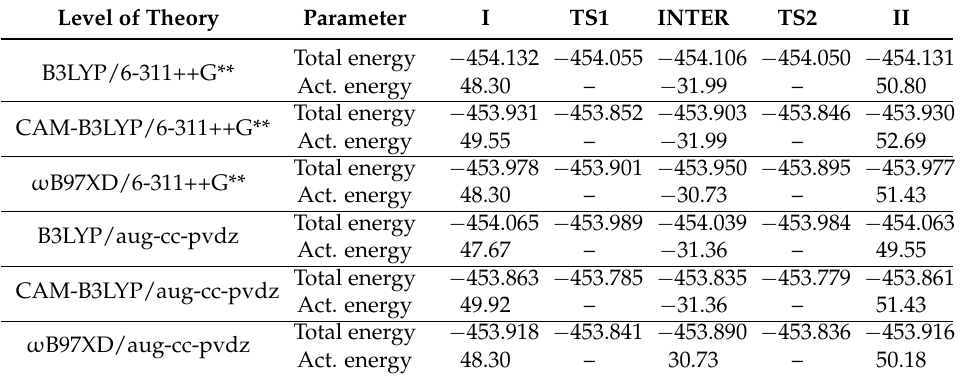
Table 5. Zero-point electronic energies (a.u.) and activation energies (kcal/mol) of the tautomerization of imidazole-4-acetic acid (I) and imidazole-5-acetic acid (II) through two transition states (TS1 and TS2) and an intermediate (INTER) using B3LYP, CAM-B3LYP, and ω B97XD functionals with 6-311++G** and aug-cc-pvdz basis sets.